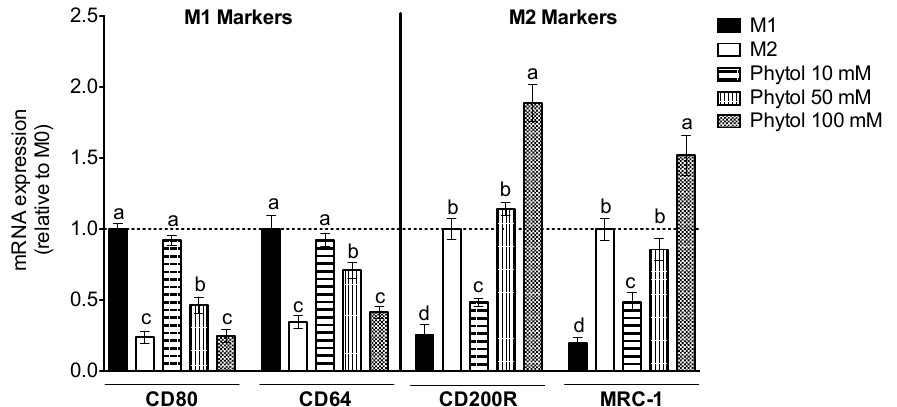
Figure 3. Effect of Phytol on polarization into M1 or M2 macrophages. M0 macrophage cells were treated with LPS and IFN γ for the M1 control, with IL-4 for M2 control, or with 10–100 mM phytol for an additional 24 h. RT-qPCR was used to measure the relative gene expression of the markers CD80, CD64, CD200R, and MRC-1. The values are means ± SD (n = 3) and, when marked with different letters, they are significantly different ( p < 0.01).